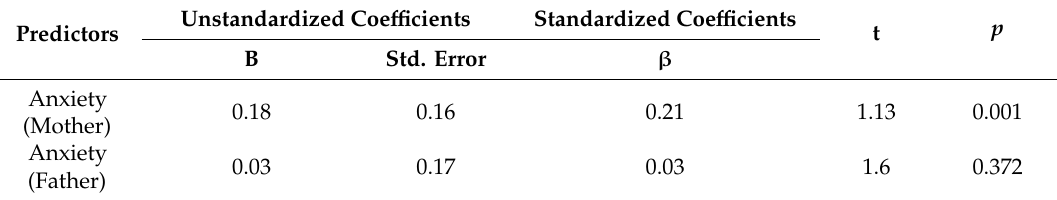
Table 3. MRA coe ffi cients of the contribution of attachment to each of the parents to anxiety in attachment relationships with the partner